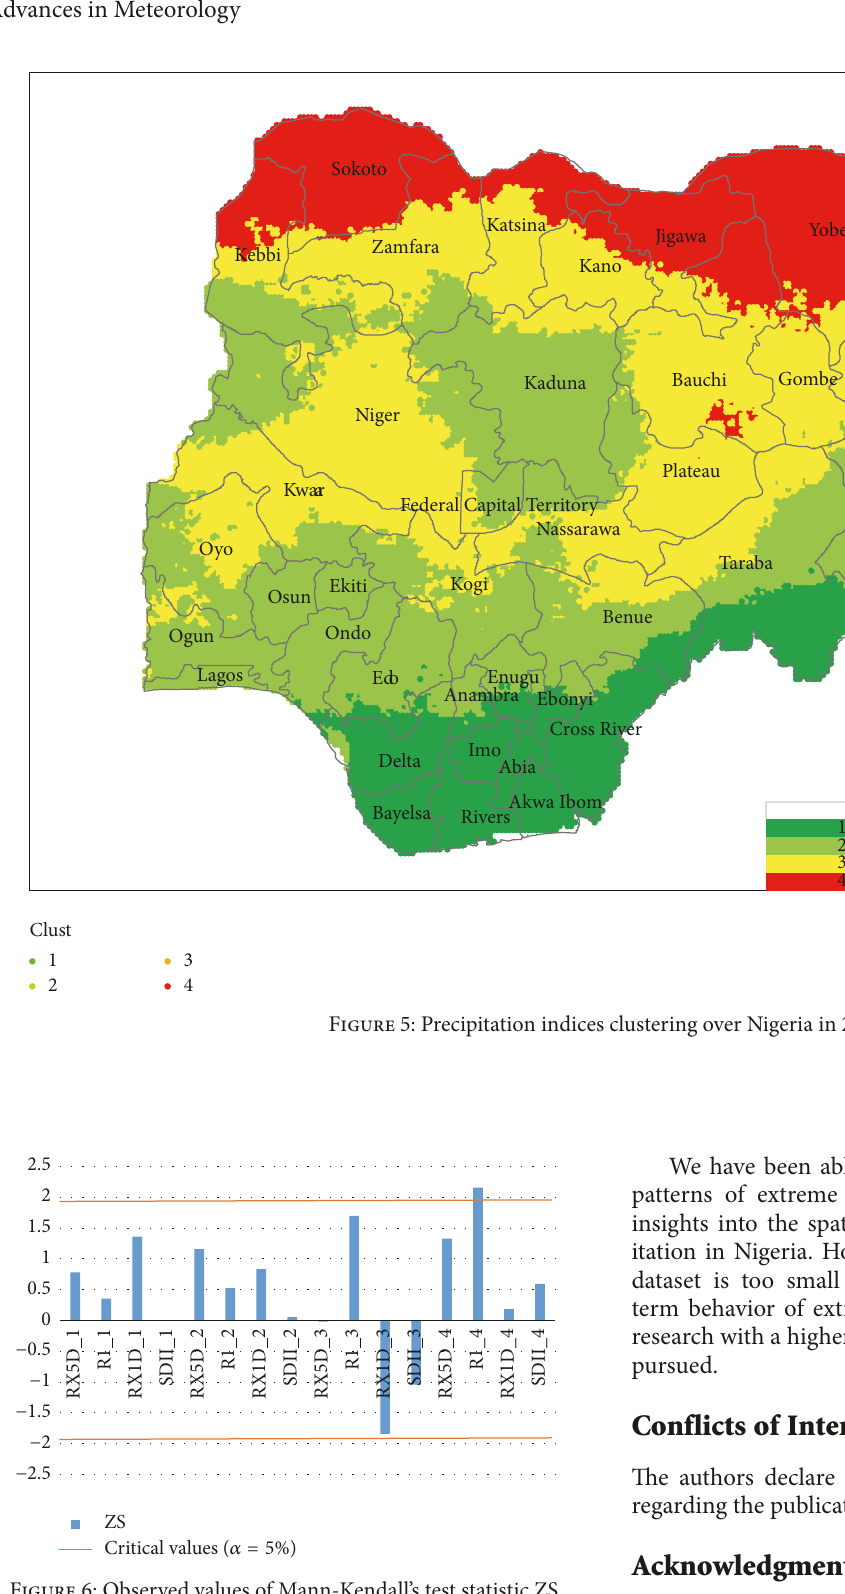
agricultural practices will be important in determining future crop yields in the